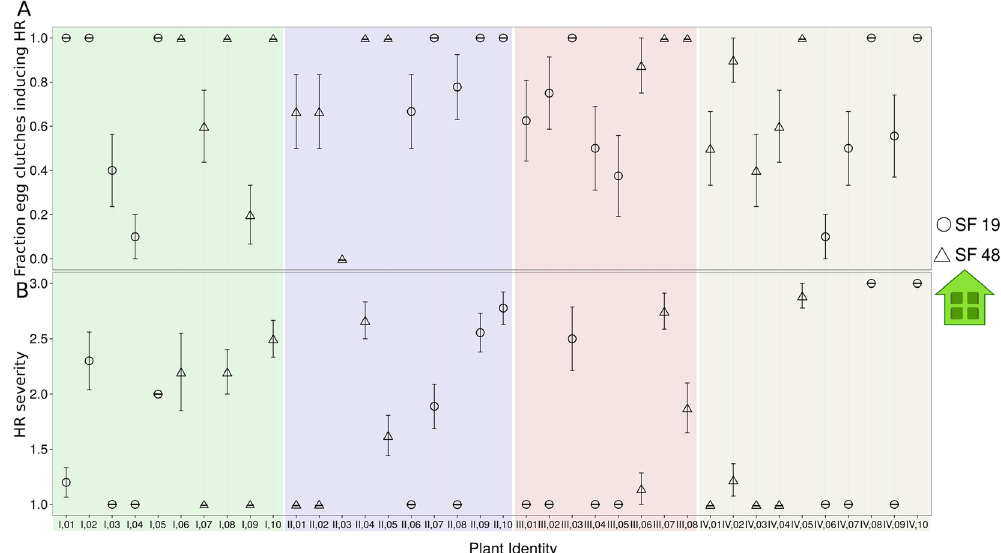
Figure 2. HR induced by P . brassicae eggs in different plant individuals from two accessions under greenhouse conditions. ( A ) Fraction of egg clutches expressing HR per plant (mean ± SD). ( B ) Severity of HR when HR is expressed in plants (mean ± SD). Four different replicates and therefore plant/butterfly sets were used and marked with differently shaded background and (Latin) numbers for plant identity. Both plant accessions, SF19 and SF48 are separated using different shapes for data points, (see explanation in the